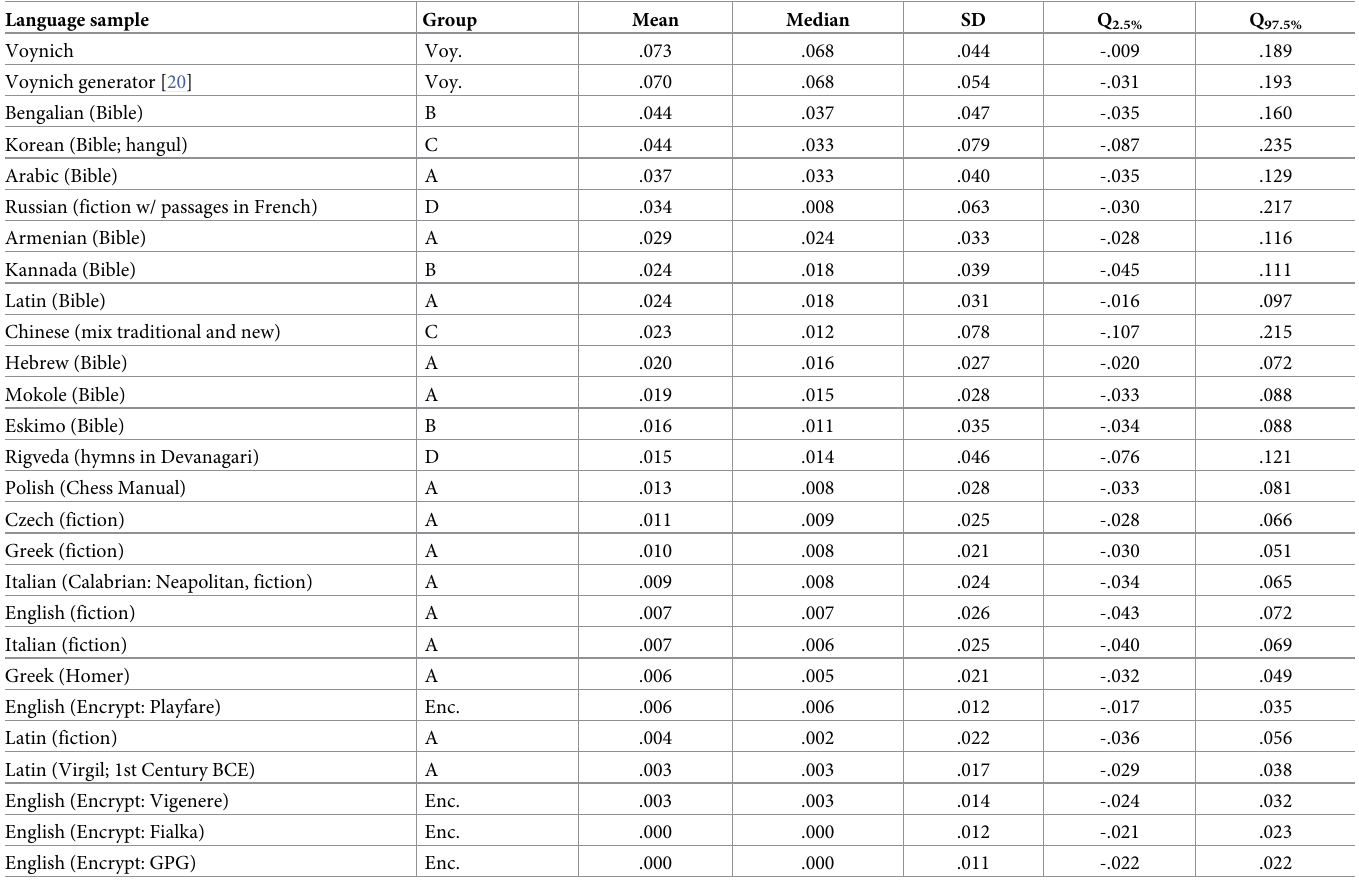
Table 4. Description of ACF values distributions of all contained symbols for various language